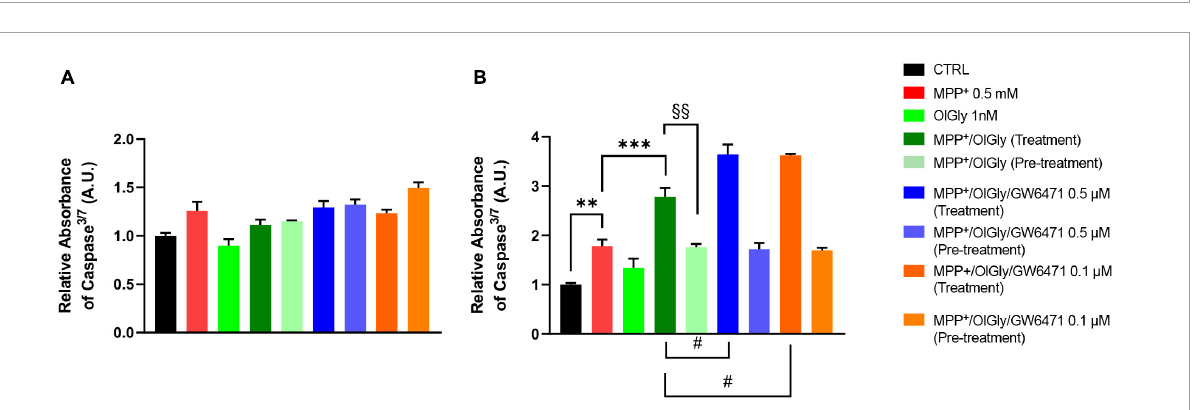
FIGURE5 Levels of Caspase 3/7 activity in (A) not differentiated and (B) differentiated SH-SY5Y cells determined by using the ApoTox-Glo triplex assay. Histograms represent the percentage, with respect to control cells (CTRL, 100%), of viable cells after the exposure to MPP + (0.5 mM), OlGly (1 nM), and GW 6471 (0.5 and 0.1 µ M) in both simultaneous treatment and pre-treatment experiments. Data are represented as mean ± SEM. ∗ Indicates values statistically significant vs. MPP + ; # indicates values statistically significant vs. MPP + / OlGly (simultaneous treatment); + indicates values statistically significant vs. MPP + / OlGly (pre-treatment); § indicates values statistically significant of MPP + / OlGly (simultaneous treatment) vs. MPP + / OlGly (pre-treatment). Student’s t -test was used for statistical analysis ( N = 6). ∗∗∗ Indicates values statistically significant with p < 0.001; ∗∗ and §§ indicates values statistically significant with p < 0.01; # indicates values statistically significant with p < 0.05.